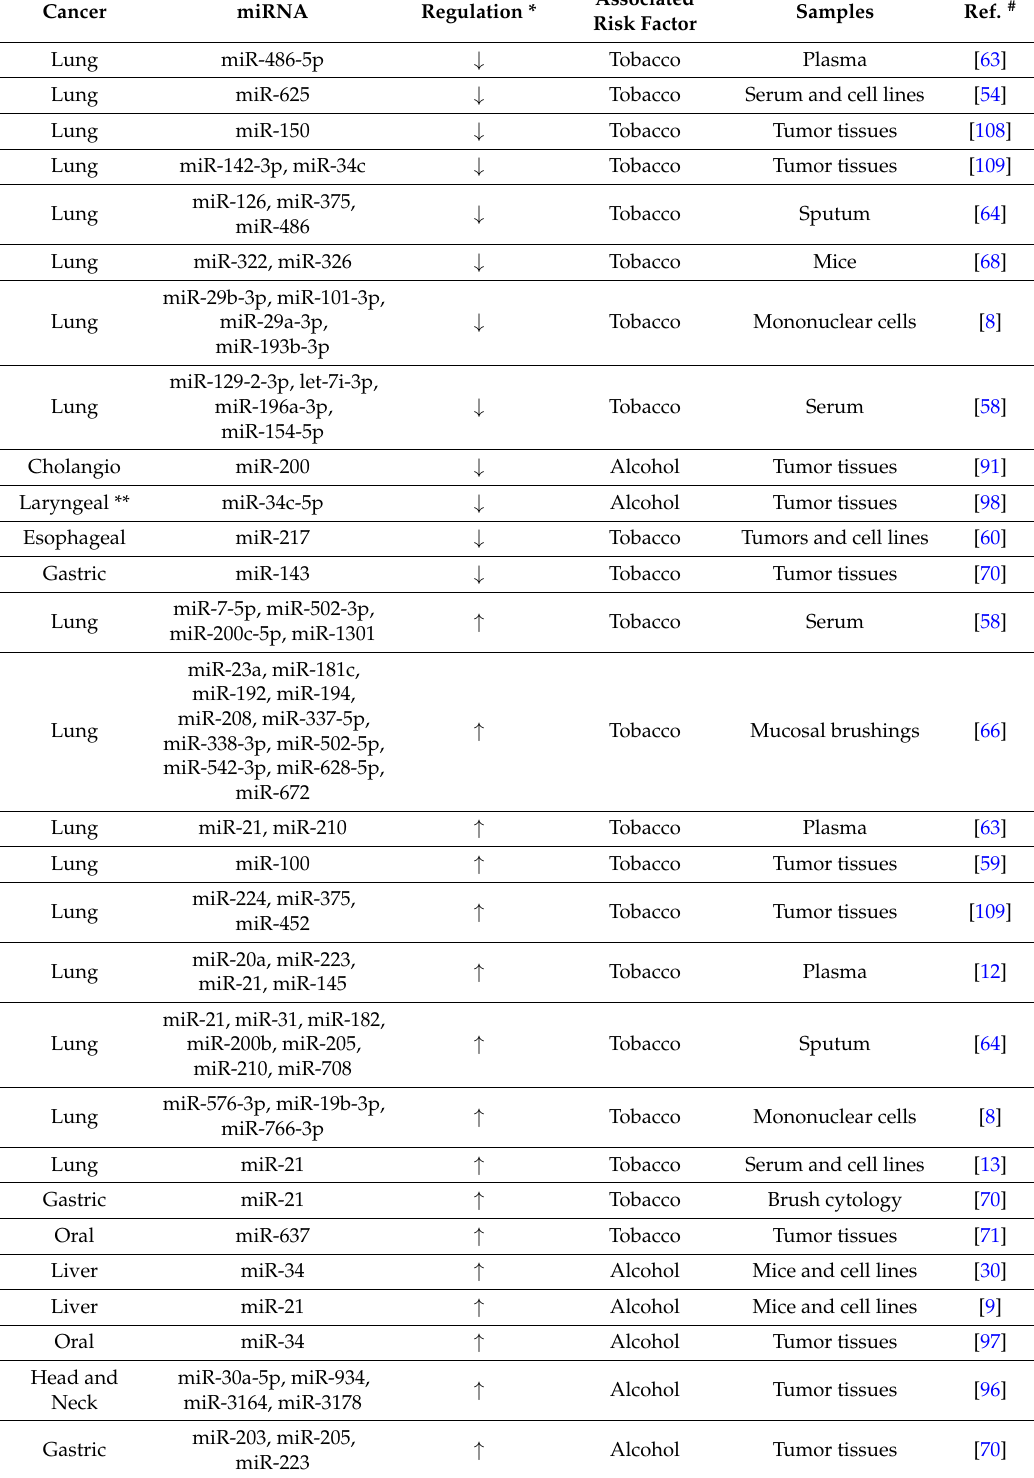
Legends: * Regulation: Green arrows indicate miRNA downregulation; Red arrows indicate miRNA upregulation; ** Premalignant lesion; Ref. # : References; All miRNAs reported in this table have been altered by exposure to alcohol or